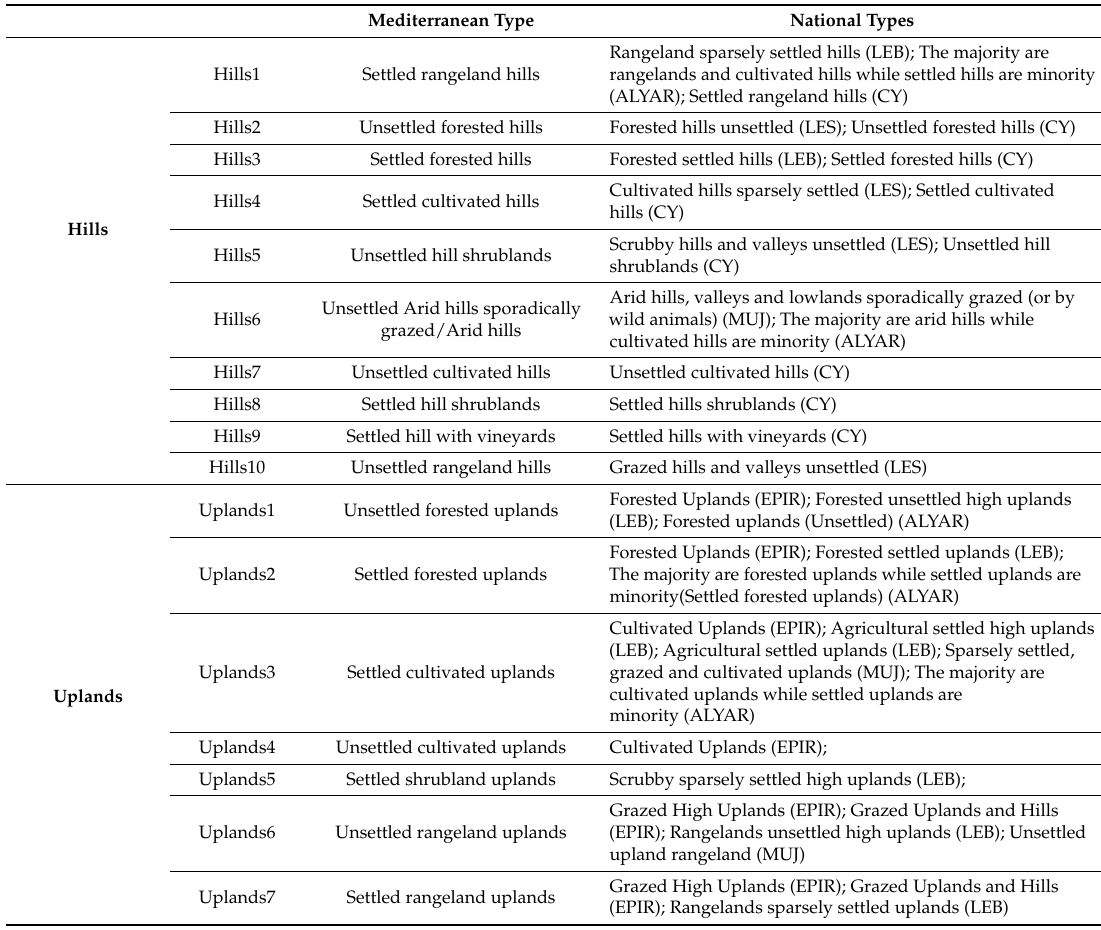
Table A1. LEB = Lebanon, ALYAR = Al Yarmouk, CY = Cyprus, LES = Lesvos, MUJ = Mujib, EPIR =